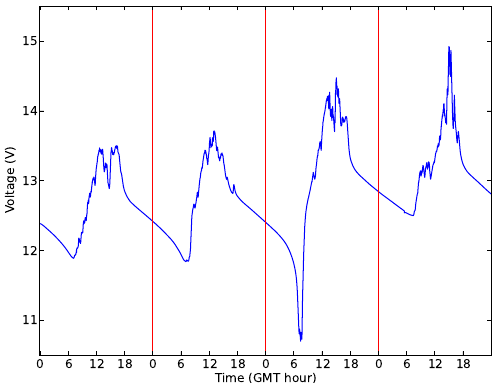
Figure 18. Evolution of external battery charge using a 30W solar Fig. 17: Evolution of internal battery charge using 10W solar panel on a sunny day. panel